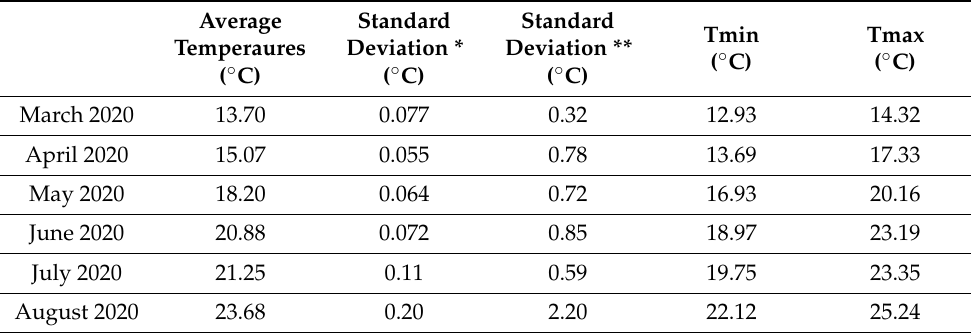
Table 2. Environmental parameters measured in LabMARE.